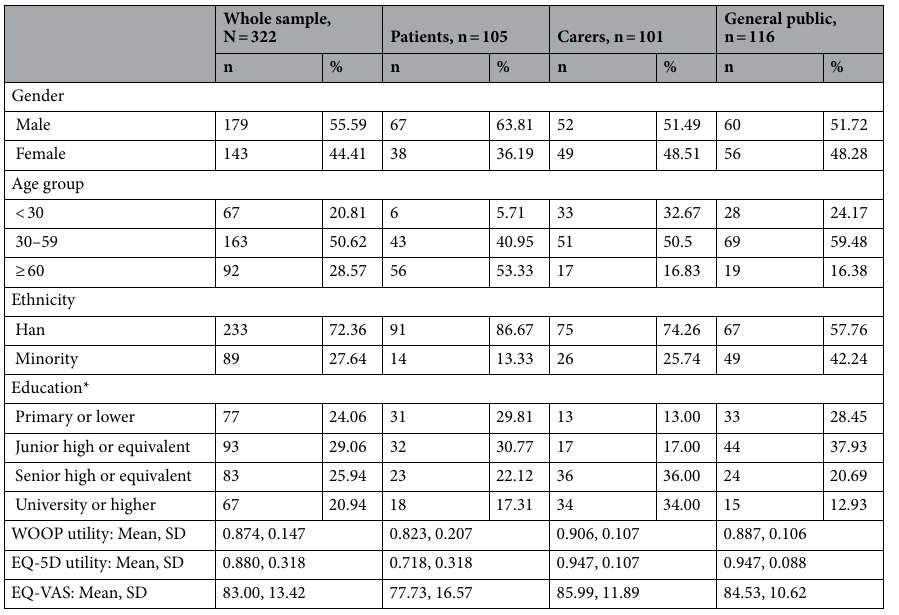
Table 1. Demographic information of the sample, n = 322. *With one missing response from the patient group and carer group respectively. # WOOP utility, EQ-5D utility and EQ-VAS were based on the sample without any missing responses, n =